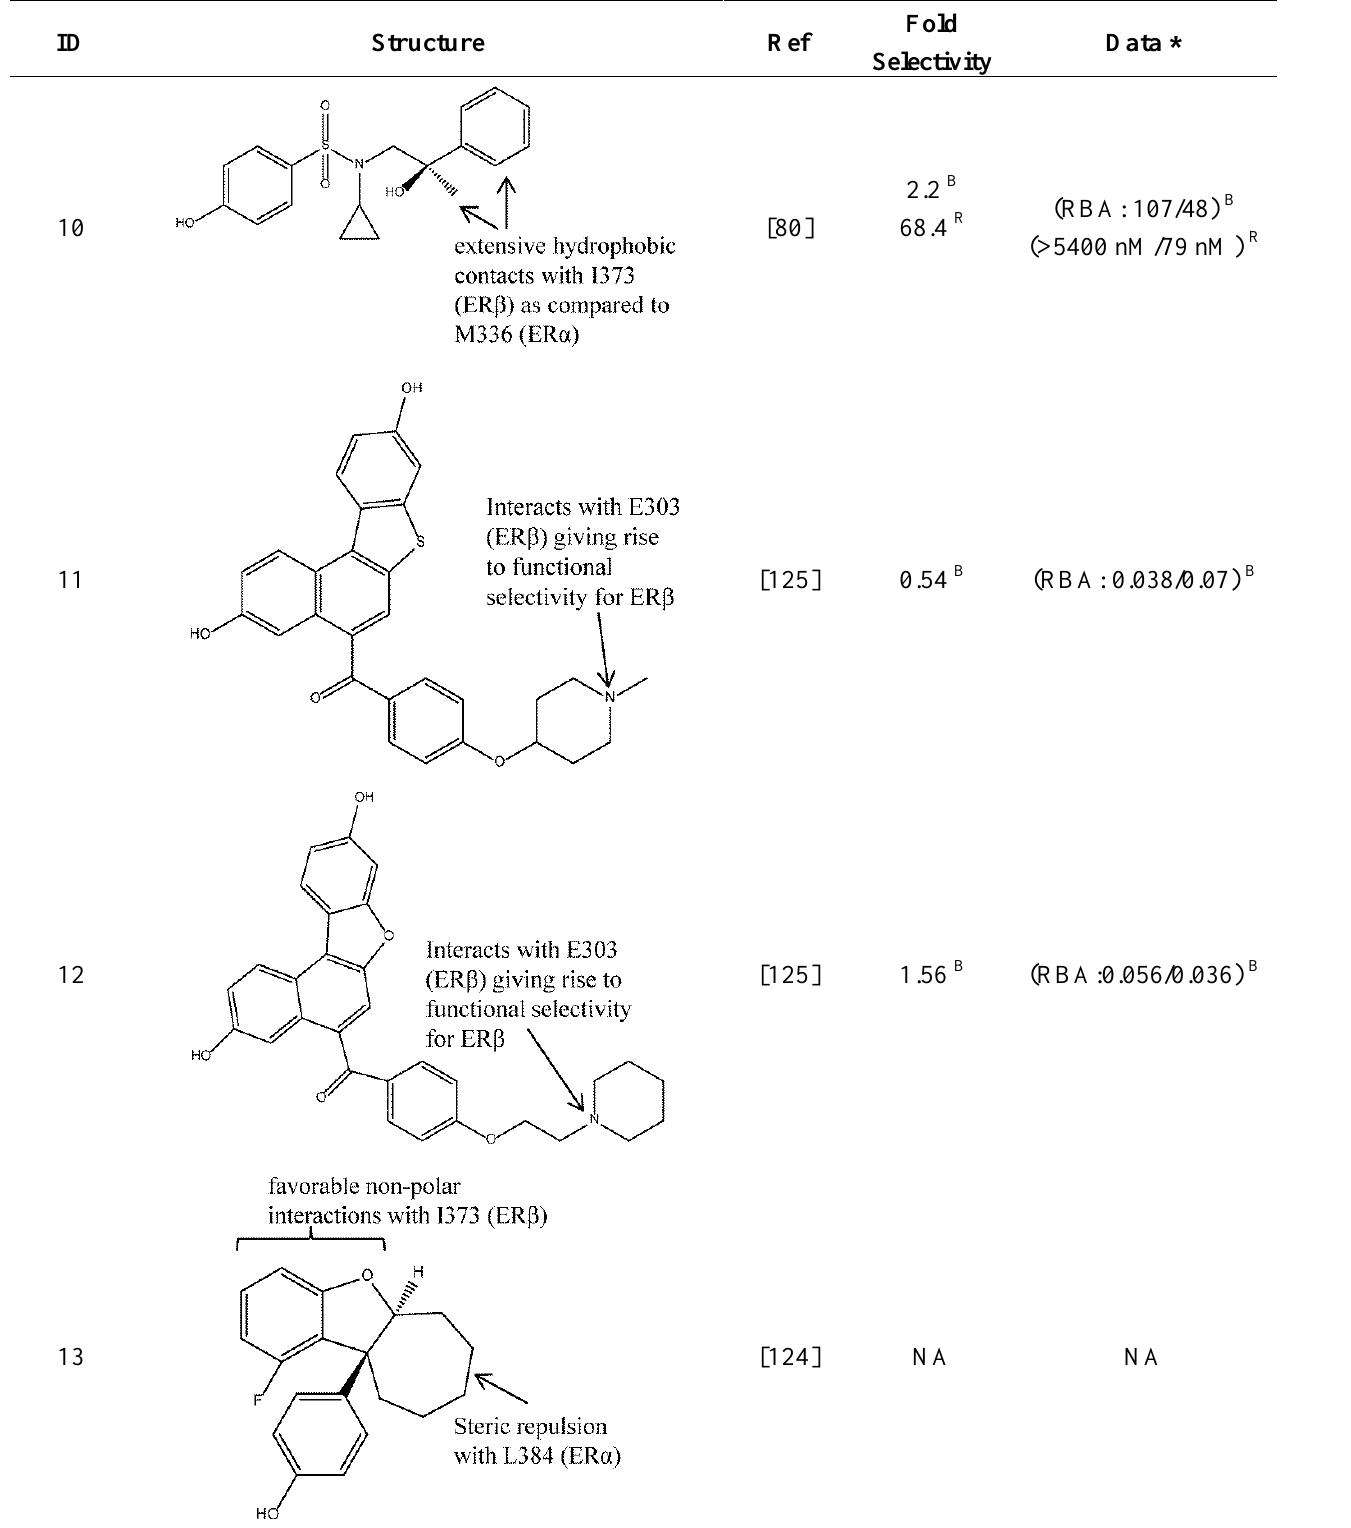
Table 4. ERβ selective compounds with their respective fold selectivity for ER β . * Data for assays performed: the first number indicates data for ER β and the second number indicates data for ER α ; In superscript, B indicates binding assays, R indicates HEK 293 reporter gene assays. NA indicates where binding data is not available but functional data discussed in main text. ID indicates the compound number that is cited in the